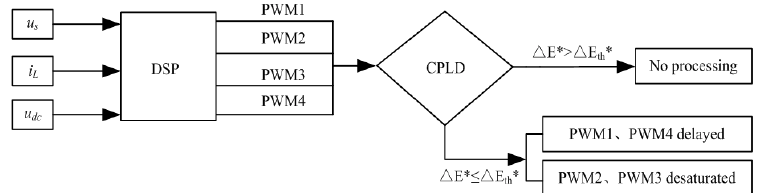
Figure 9. Logic block diagram of the desaturation control for the threshold of the loss decrement per-unit value.